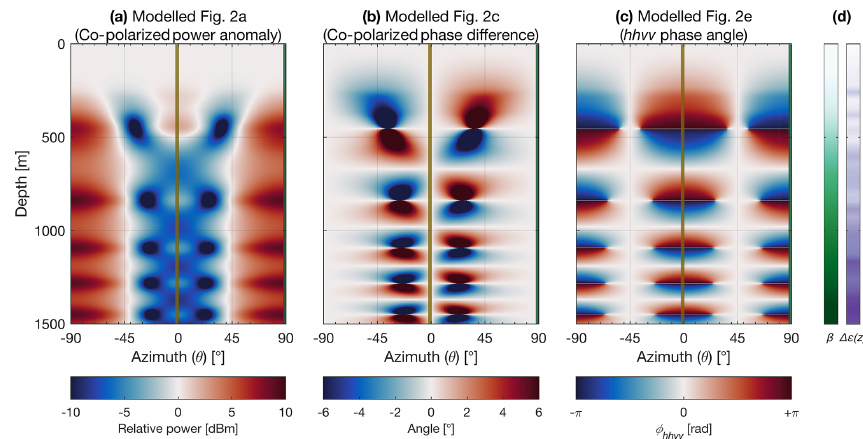
Figure 5. Modelled (a) co-polarized power anomaly, (b) co-polarized phase difference, and (c) quad-polarized ( hhvv ) phase angle, corre- sponding to Fig. 4a, c, and e respectively. (d) Model input parameters for the ratio of anisotropic scattering ( β ) and birefringence anisotropy ( (cid:49)ε(z) ) through depth, the former estimated through 2-D optimization from Fig. 4b and the latter using eigenvalues from the WAIS Divide ice core that specify the bulk COF (Fitzpatrick et al., 2014; Voigt et al., 2015). Value ranges for β (white to dark green) and (cid:49)ε(z) (white to dark purple) are [ 0 15 . 6 ] dB and [ 0 1 . 5 × 10 − 2 ] respectively. The orientation of the E 1 (dark green) and E 2 (dark yellow) eigenvectors was prescribed depth-invariant at 89 ◦ and − 1 ◦ respectively following measured observations.